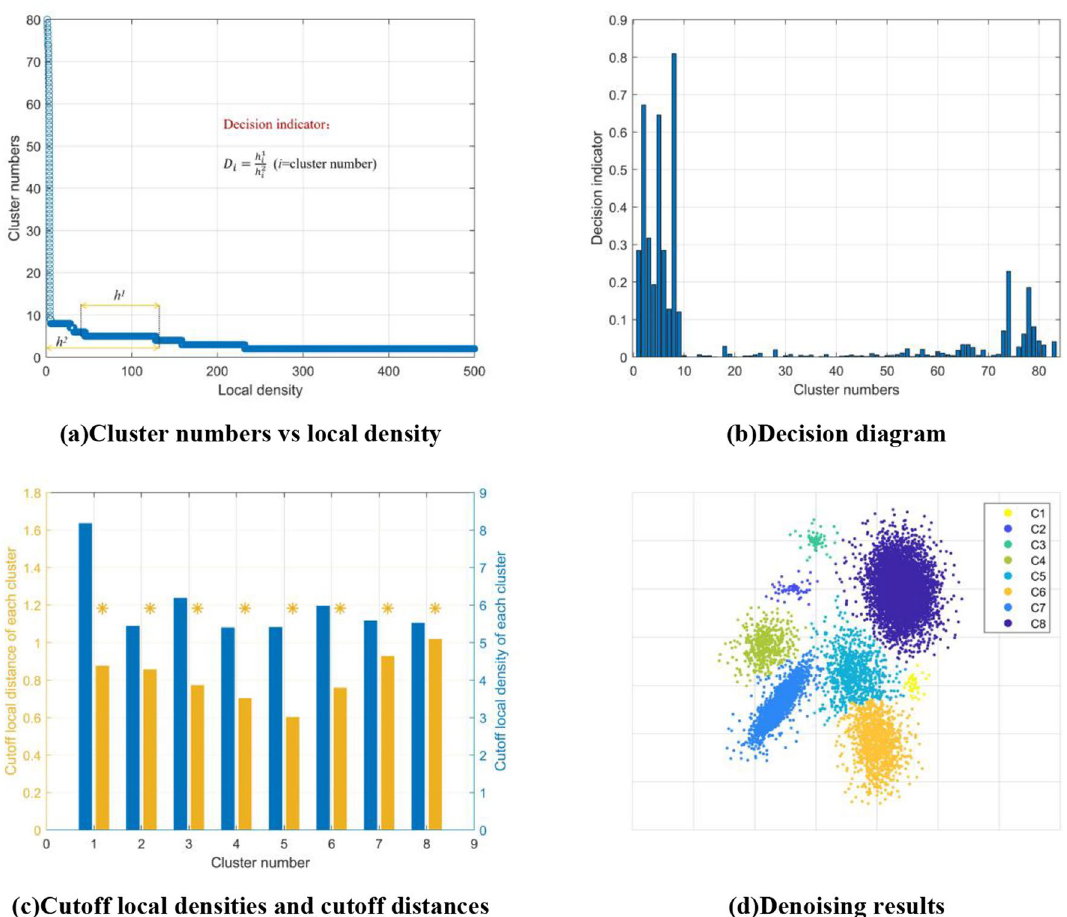
Figure 4. BCALoD noise recognition. ( a ) The number of clusters filtered from small to large local density. When the local density gradually increased, it was observed that the number of clusters gradually decreased. When the local density was small, the number of clusters decreased sharply, and the data points deleted during this period were noise points. When the cutoff local density increased to a certain value, the number of clusters became 1. ( b ) The clustering indicator of the noise-containing 2D Gaussian mixture distribution dataset was calculated. The highest value of the decision indicator D i was used as the best clustering indicator. To save data points as much as possible, the smallest local density when the decision indicator reached the maximum was selected as the cutoff local density to denoise the dataset. Six clusters were calculated in the dataset. ( c ) Cutoff local densities and cutoff distances of each cluster respectively. There, the yellow point is the initial cutoff distance. (d) The final denoising clustering result calculated by BCALoD. After noise recognition, the number of clusters was corrected form 96 to the true value,